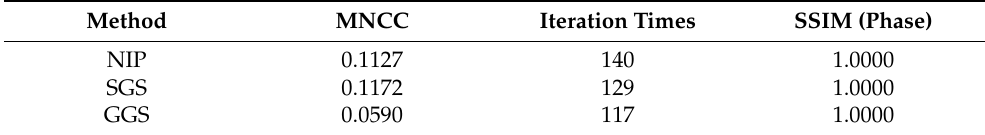
Table 2. The reconstruction performance under different types of the holographic design